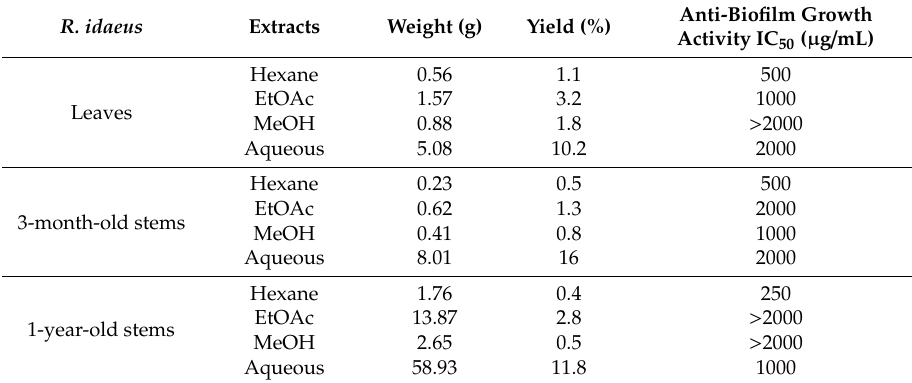
Table 1. Weight, yield and anti-biofilm growth activity against C. albicans of hexane, ethyl acetate, methanolic and aqueous extracts obtained from R. idaeus leaves, 3-month and 1-year old stems. Biological results are expressed as 50% inhibitory concentration ( p < 0.05). All experiments were carried out in triplicate with at least three replicate experiments.